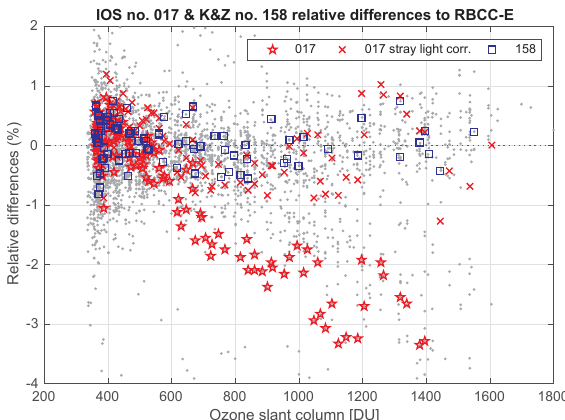
Figure 10. Percentage mean difference for the simultaneous direct sun measurements with the reference for all the participating instru- ments, with and without the standard lamp correction, in the stray- light-free OSC region (OSC < 900). (The Brewer no. 151 is an not operative brewer, is not providing reliable data, and is outside the